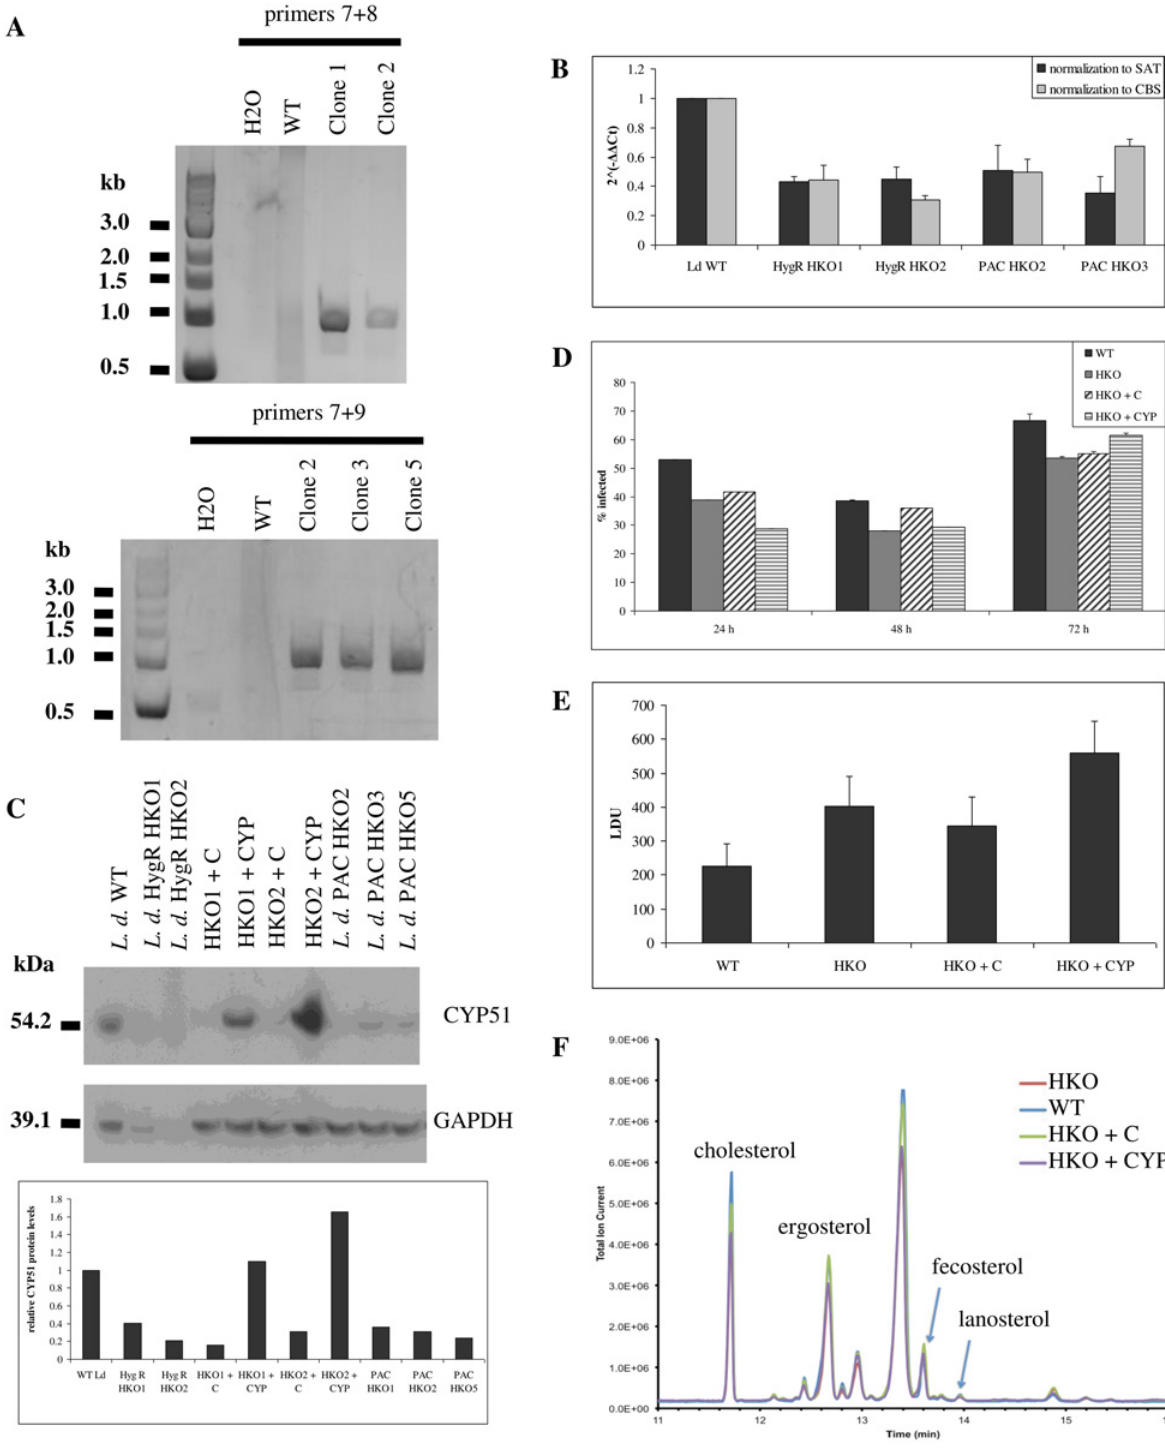
Fig 1. Modulation of CYP51 levels in L . donovani . A , Replacement of a CYP51 allele by homologous recombination. Correct targeting of the knockout cassettes was verified by PCR using one primer within the knockout cassette and one upstream of CYP51 (primers 7 and 8 (hygromycin), top or 7 and 9 (puromycin), bottom). B , qPCR quantification of chromosomal CYP51 levels, normalized to SAT or to CBS and to wild-type levels. C , CYP51 protein levels in half knockout and complemented strains. CYP51 and GAPDH were detected by Western blot (top) and quantified by densitometry (bottom) D , In vitro infectivity of half knockout and complemented strains. THP1 macrophages were infected at a 10:1 parasite to macrophage ratio. Cells were fixed and stained